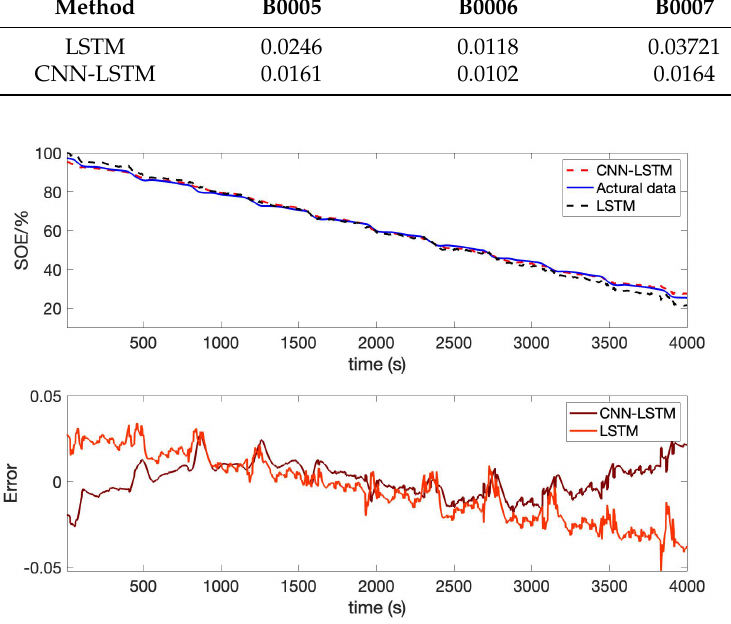
Figure 24. Battery SOE prediction results in the DST condition. Table 6. RSME comparison results.